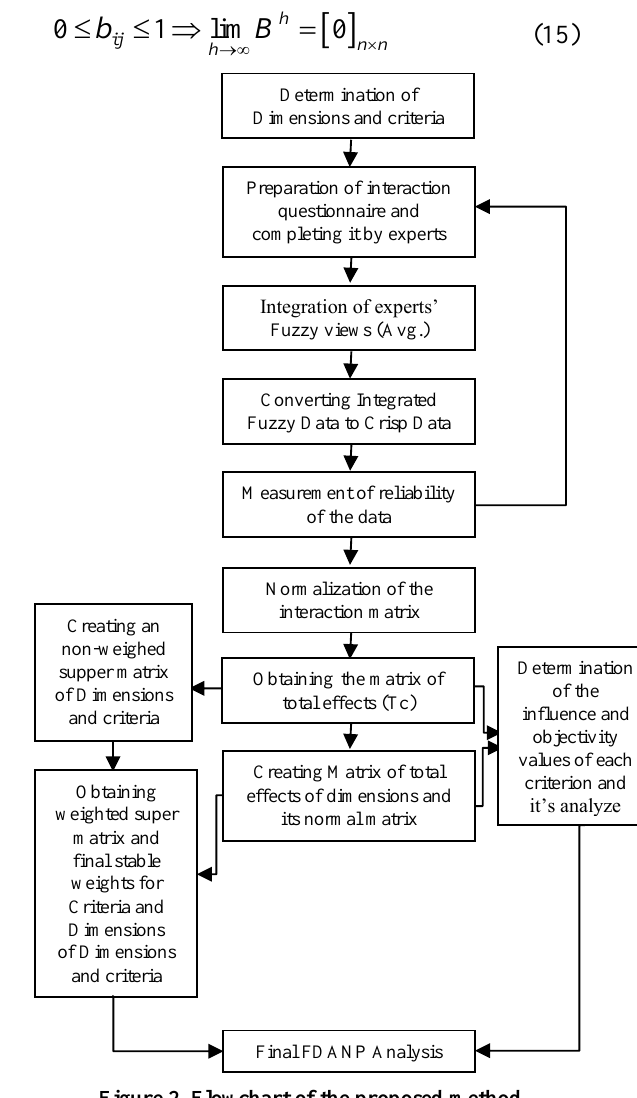
Figure 2. Flowchart of the proposed